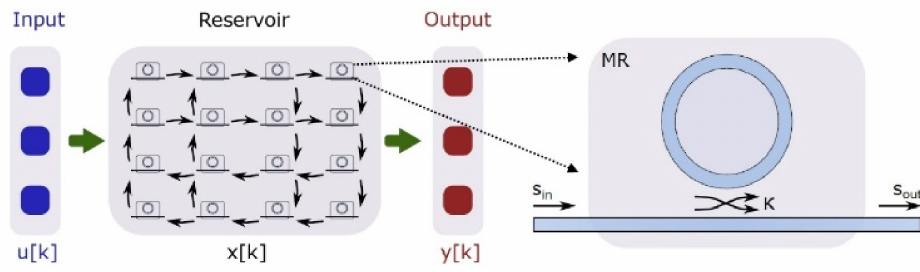
Figure 12. The reservoir with the 16 nodes made from silicon on insulator (SOI) MR